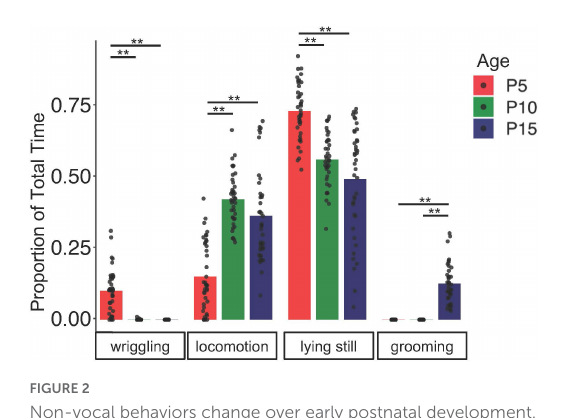
FIGURE2 Non-vocal behaviors change over early postnatal development. The proportion of time spent engaged in different non-vocal behaviors is shown for N = 40 mice at P5 (red), P10 (green), and P15 (blue). Double asterisks, p <